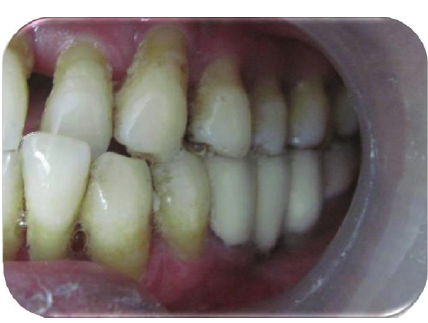
Figure 6: Final prosthesis